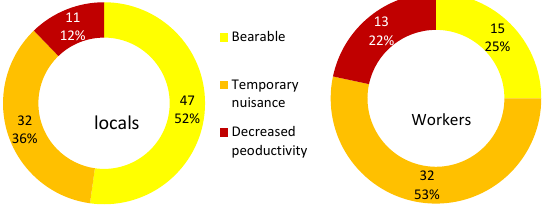
Figure 7: No. of peoples affected by heat release due to project activities w.r.t. local’s vs workers.